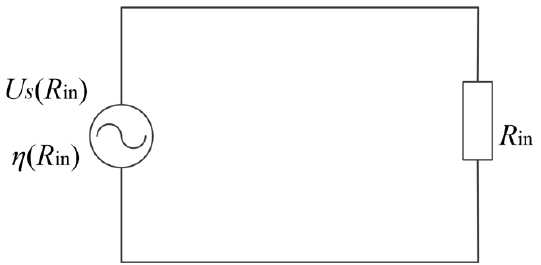
Figure 3. Simplified equivalent circuit of the proposed WPT system.